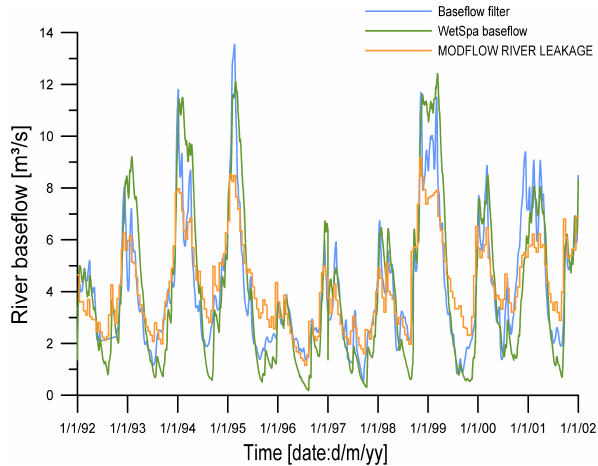
Fig. 5. Comparison of the filtered baseflow, the baseflow simulated by WetSpa and the baseflow simulated by